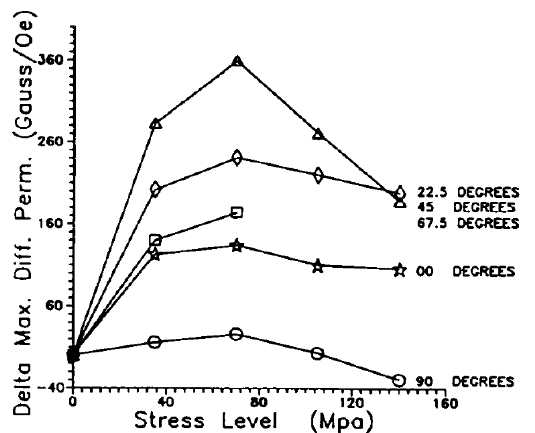
Figure 16. Maximum differential permeability relative to the stress at different angles for a specimen of polycrystalline iron containing 0.1 wt% C. Adapted with permission from Ref. [6]. Copyright 1992 Elsevier Science .